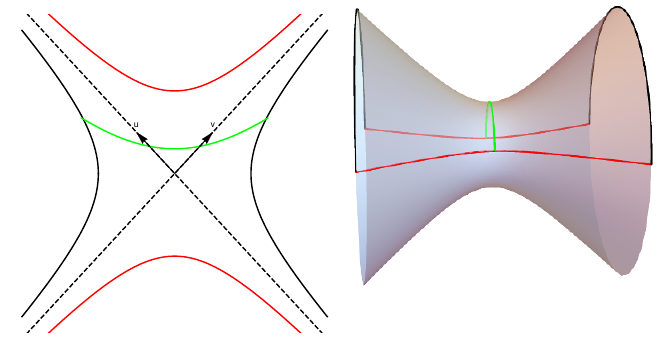
Figure 11. Left: the HRT surface (green) is a pair of geodesics crossing the wormhole anchored at the same boundary time on the left and on the right. Right: the topology of a spatial slice is that of a cylinder. We draw schematically a spatial slice which contains the E p